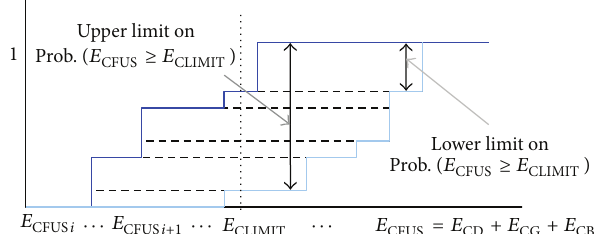
Figure 10: Curves bounding the true cumulative distribution function (cdf) of the fused output 𝐸 expectation of casualties’ random variables generated, respectively, by blast propagation, debris fragmentation, and gas dispersion. 𝐸 is defined as the fused expectation of casualties random CFUS variables generated by